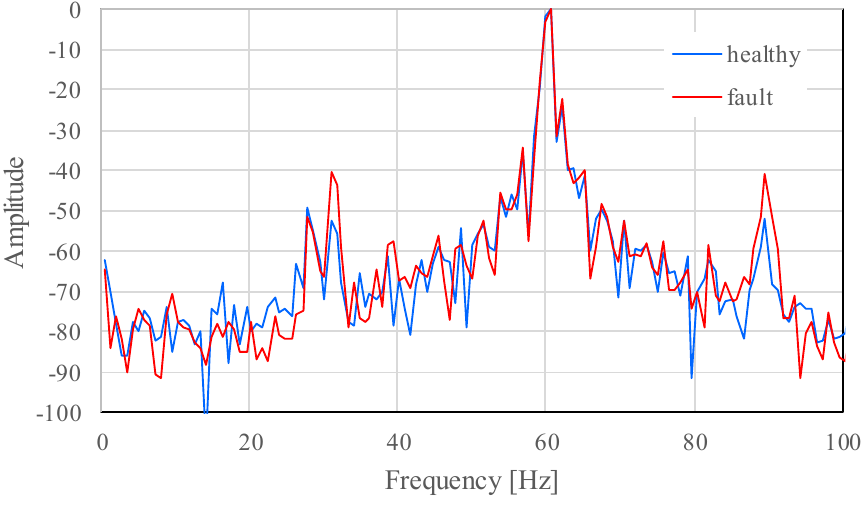
Figure 3. Spectrum of current rotating at 1750 min − 1 .